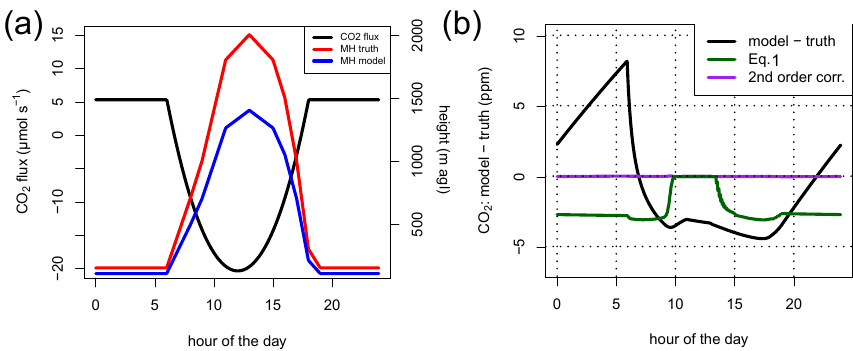
Fig. 3. The surface fluxes ( F NEE ) used for the 1-D conceptual model (Eq. 2) with 24h mean ∼ 3.4µmols − 1 , also shown are the prescribed mixing heights for the truth (red line) and the model with a 30% low bias (blue line) (a) . Also shown in (b) is the Diurnal variation of the CO 2 difference ( C m , model − C m , truth ) (black line) resulting from 1-D conceptual model (Eq. 2). The green line shows the same error after applying the reshuffling method (Eq. 1) to the model ML CO 2 ( C m , model ). Taking into account the residual layer mole fraction completely compensates for the difference (purple line).